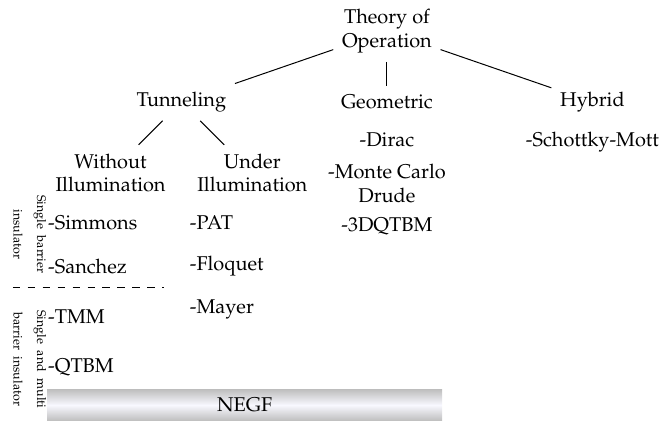
Figure 5. Categorization of the theory of